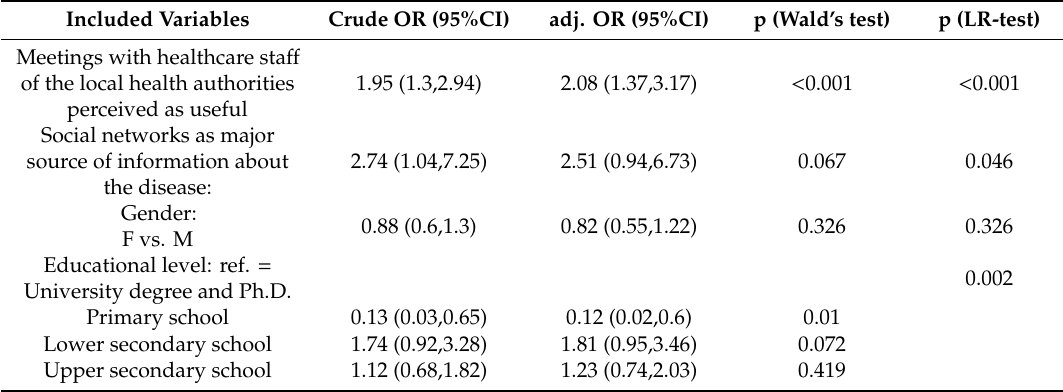
Table 3. Final results of logistic regression, binary risk among parents who perceived a moderate and high risk at T0. Log-likelihood = –286.451(OR = odds ratio; adj = adjusted; CI confidence interval; LR-test = likelihood ratio test; AIC value = Akaike’s Information Criterion